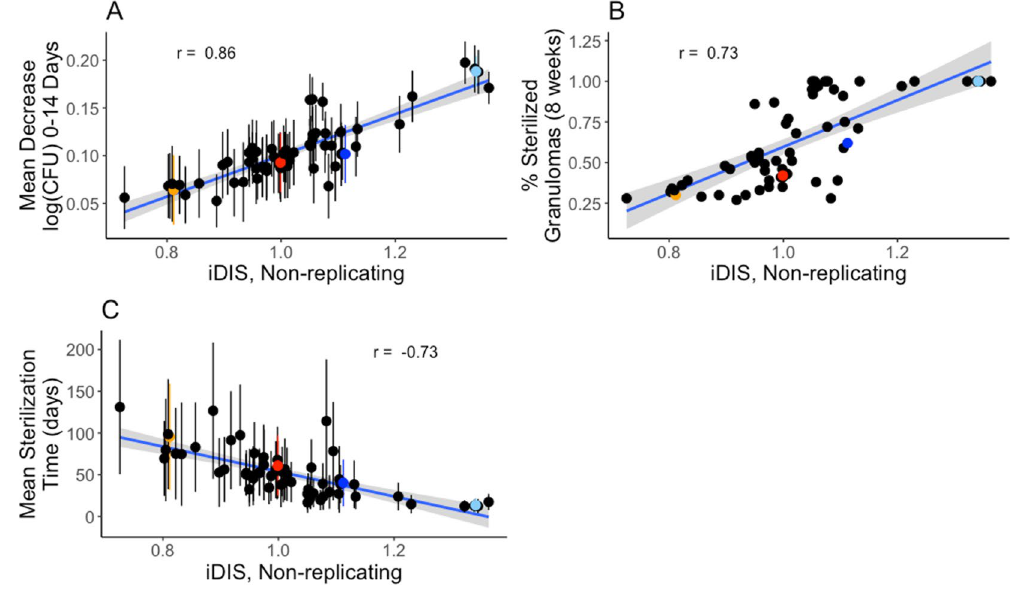
Figure 3. Regimen efficacy is correlated with the in vivo Drug Interaction Score (iDIS). iDIS associated with non-replicating Mtb killing is evaluated for 3 measures over 64 simulated drug combination regimens. The decrease in log CFU (0–14) averaged over 100 granulomas simulated for each regimen ( A ) and percentage of sterilized (negative) granulomas after eight weeks of treatment ( B ) are positively correlated with iDIS of non- replicating Mtb during the first 24 h of treatment (correlation coefficients of 0.86 and 0.73, respectively). Mean sterilization time for each regimen over 100 granulomas ( C ) is negatively correlated with iDIS of non-replicating Mtb (correlation coefficient of − 0.73). Each point represents the regimen outcome measurement for a given regimen and error bars indicate ± standard deviation from the sample of 100 granulomas simulated. The 64 drug regimens simulated are listed in Supplementary Table 1. The colored points correspond to the regimens HRZE (light blue), RE (dark blue), RM (red) and HE (orange) for emphasis. Plots were made using the ggplot2 package in R 39